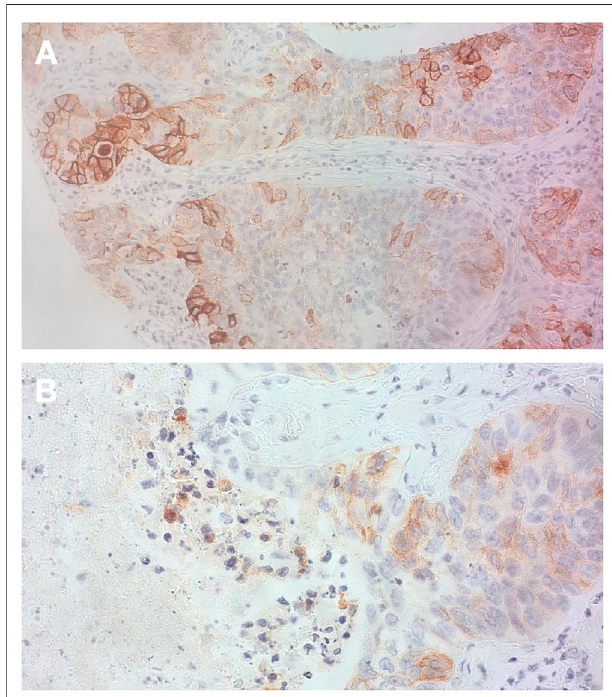
FIGURE 5 | IHC analysis for PD-L1 (A) This picture highlights heterogeneity in term of PD-L1 expression in tumor cells (20 X magni fi cation); (B) Weak PD-L1 positivity mainly on tumor cells (also macrophages and very few stromal lymphocytes are positive) (40 X magni fi cation).